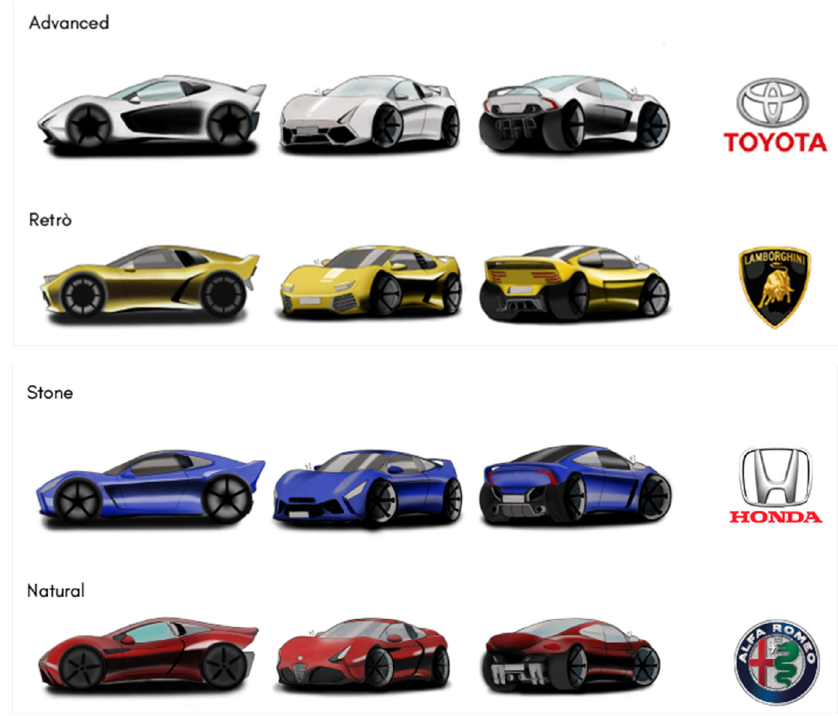
Figure 17. Sketches and assigned brands for Different Styles.